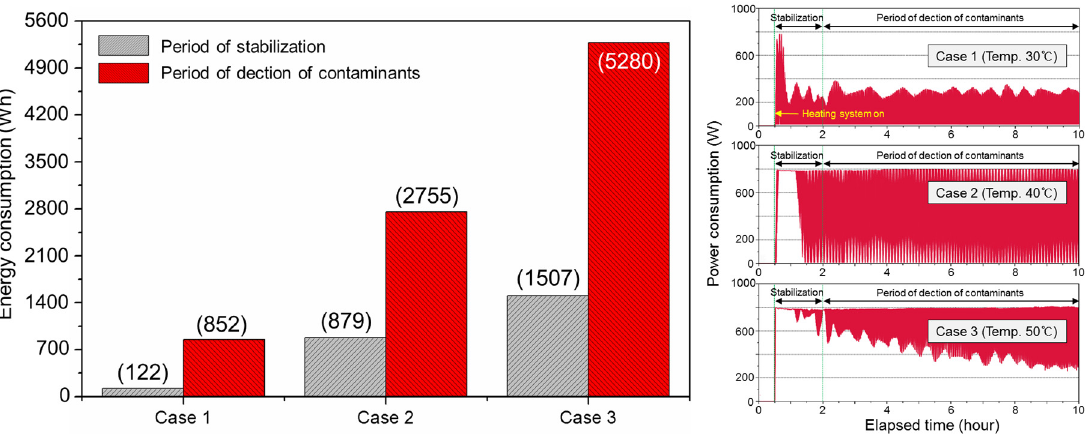
Figure 5. Energy and power consumption from heating under PID (proportional integral derivative) control each Case.